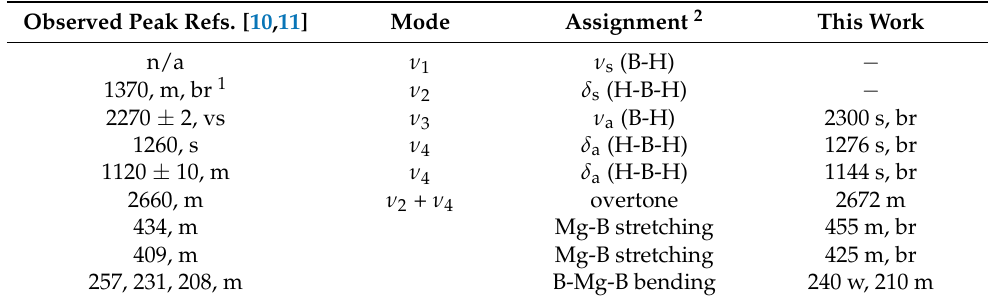
Table 3. FTIR features of γ -Mg(BH 4 ) 2 from literature and this work (orange curve on Figure 3). All of the frequencies are in cm − 1